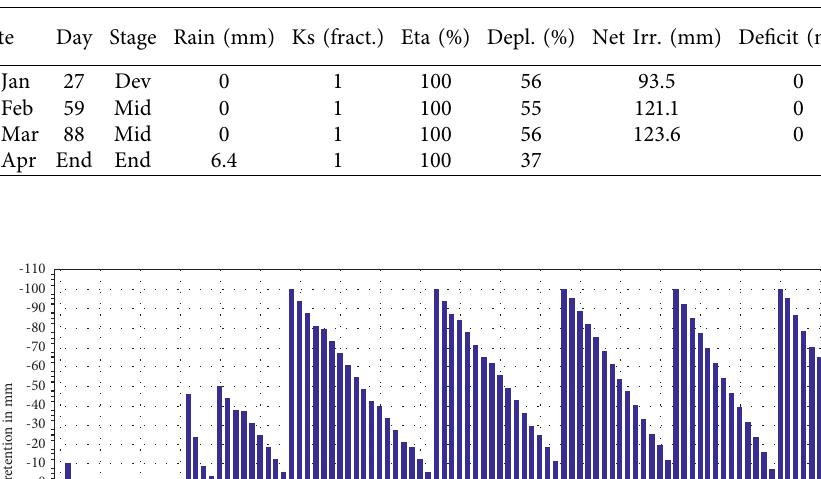
Table 16: Barley irrigation schedules.